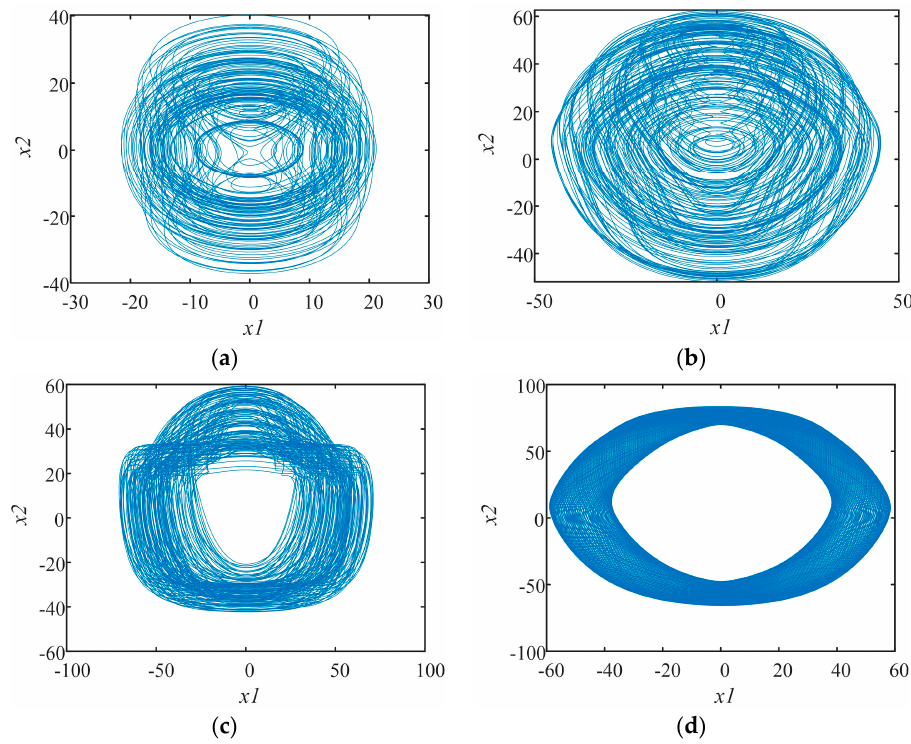
Figure 6. Chaotic attractor of the system. ( a ) a = 2, b = 11, c = 20, d = 10, e = 1; ( b ) a = 0.3, b = 11, c = 20, d = 10, e = 7; ( c ) a = 0.3, b = 11, c = 10, d = 10, e = 17; ( d ) a = 0.3, b = 11, c = 20, d = 10, e = 13.